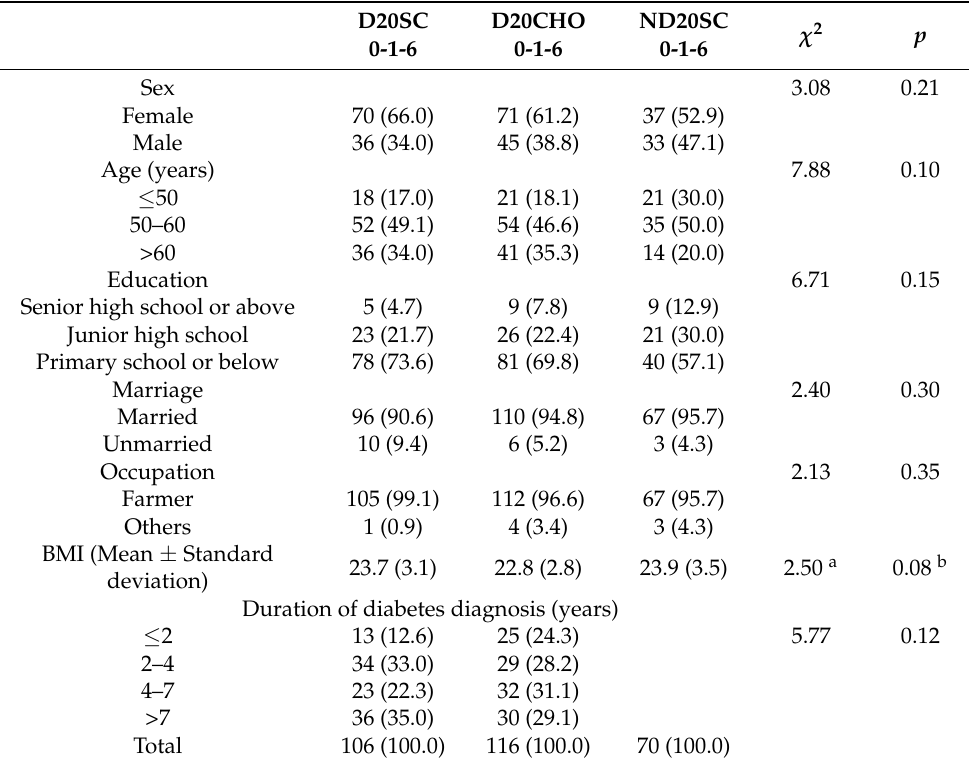
Table 1. Characteristics of participants in diabetic and healthy groups one month after being fully